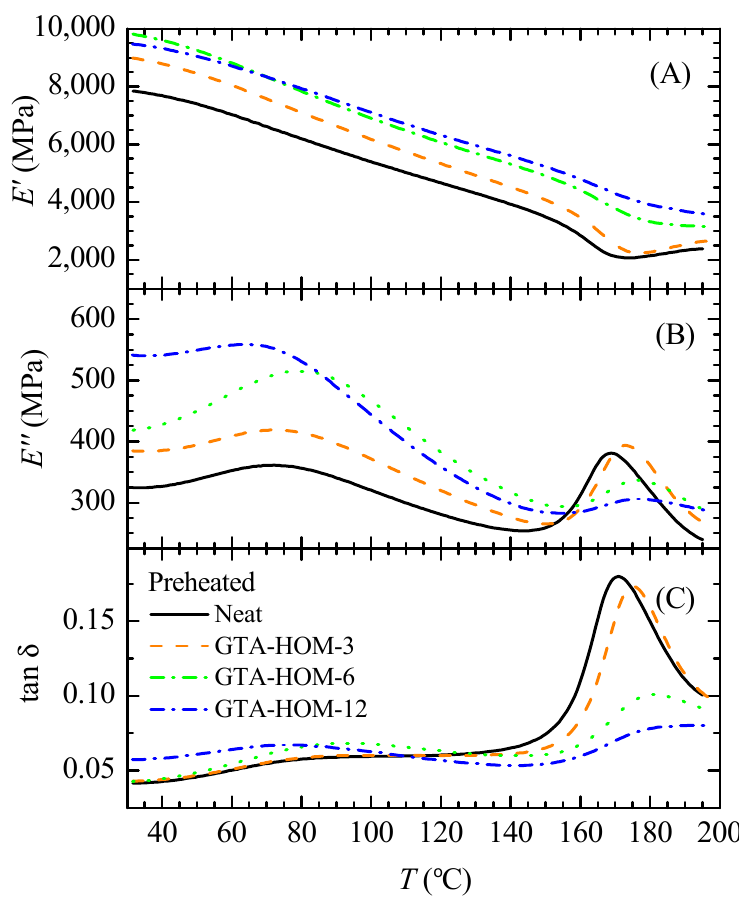
Figure 5. The plots of ( A ) storage modulus, ( B ) loss modulus, and ( C ) tan δ against temperature of preheated 3, 6, and 12% GTA-HOM films and a neat chitosan film.